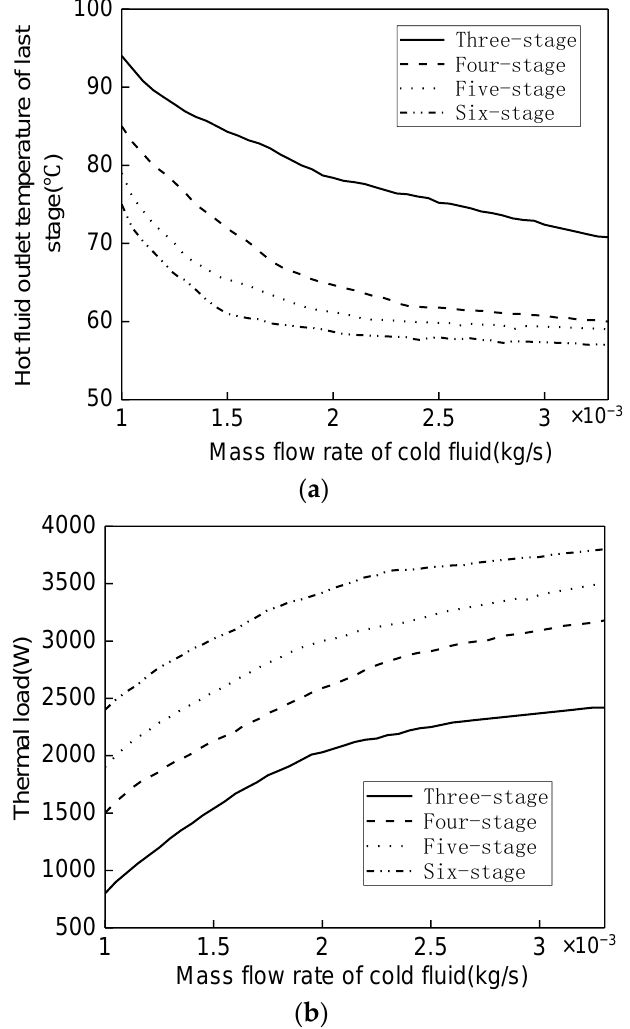
Figure 5. Comparison of the thermodynamic characteristics of the different numbers of condensers (( a ): outlet temperature; ( b ): thermal load).